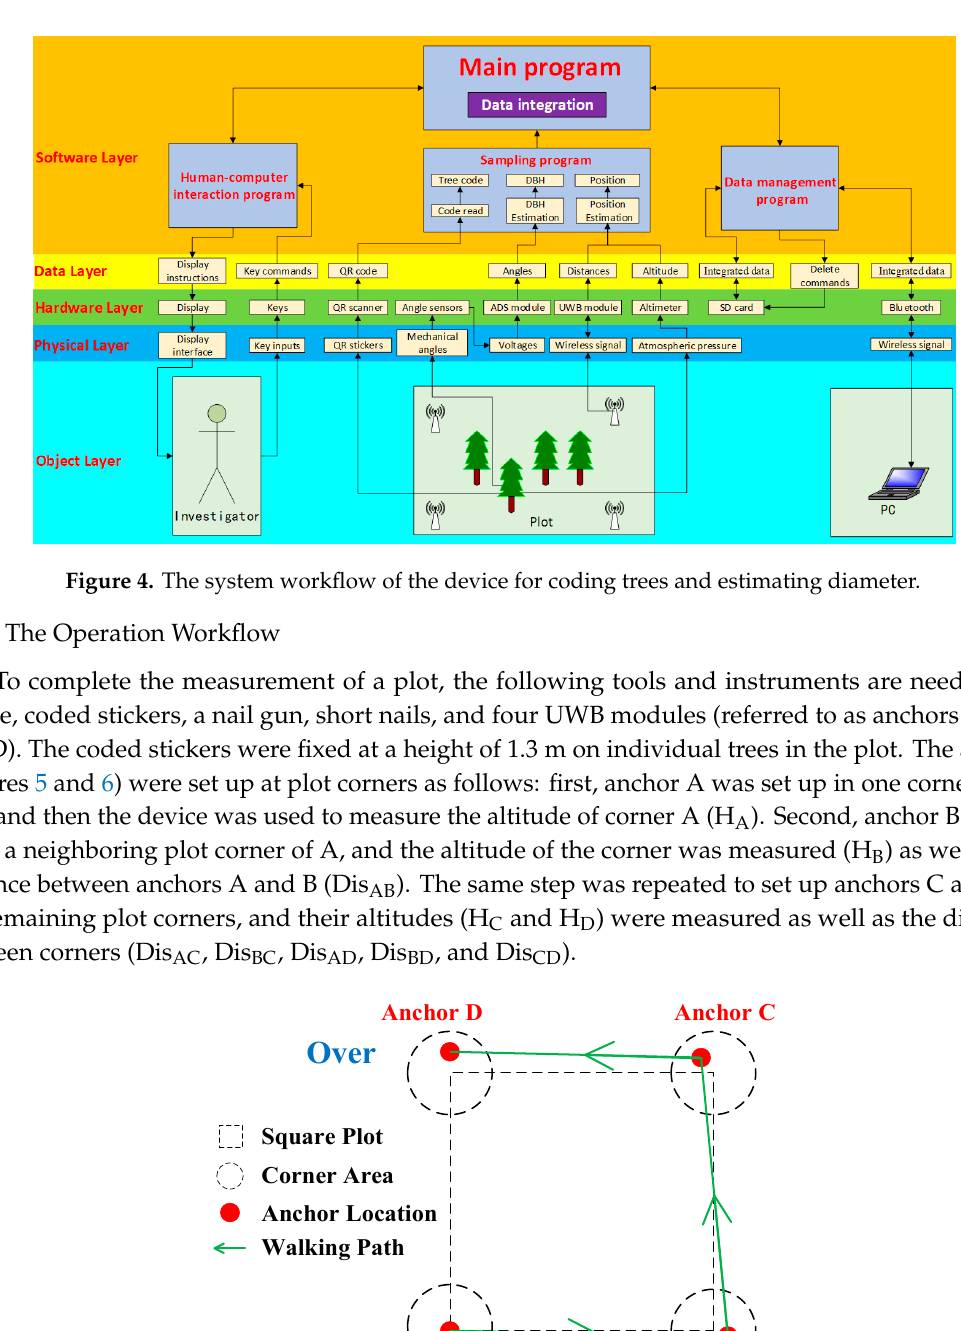
Figure 6. An example to show the anchor installation in a plot. Figure 7. Measurement of a tree. On the display screen, line 1 represents the tree code; line 2, the diameter at breast height (DBH) value of the previously measured tree; line 3, the measured DBH value; line 4, the values of α 1 and α 2 ; line 5, the value of H n ; and line 6, the values of A n , B n , C n , and D n . 3.2.3. Measurement Algorithm of a Tree’s DBH Figure 8 provides an example of measuring tree DBH using the device, with A, B, and C being the contact points of the device’s arms and beam against the tree trunk, which results in two arcs, arc BA and arc BC. Since the cross-section surface may be eccentric, arcs BA and BC have different